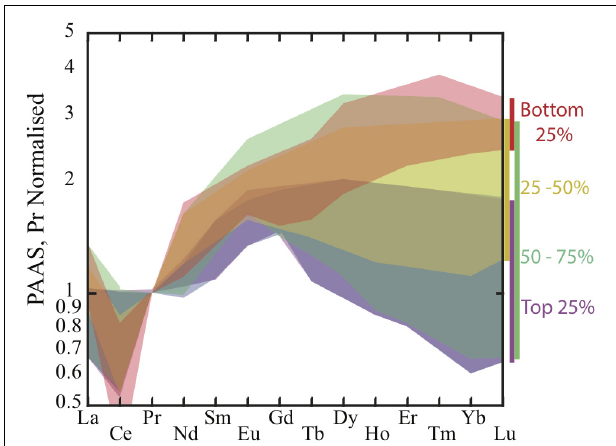
FIGURE 2 | General trends in pore water shale-normalized REE pattern by concentration. REE concentrations from North Pacific and Tasman Sea sites ( Figure 1 ) were ranked by neodymium concentration and split into quartiles, the range is displayed for each quartile. Normalized to PAAS values of Taylor and McLennan (1985). Europium data is excluded for samples with suspected oxide formation (e.g., Abbott et al., 2015b) and Samarium data is excluded for Tasman Sea samples due to a high blank.